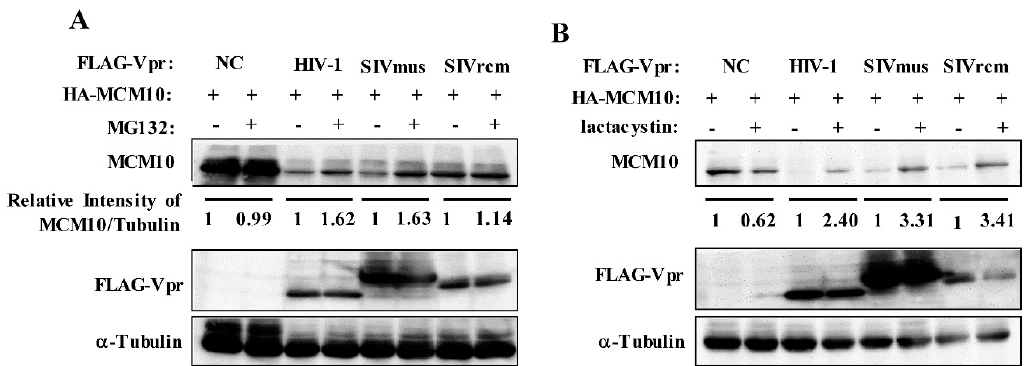
Figure 3. MCM10 degradation by HIV-1, SIVmus, and SIVrcm Vprs via proteasome dependent pathway. HEK293T cells were transiently transfected with pcDNA 3.1/HA-MCM10 together with either pcDNA3.1/3 × FLAG-HIV-1, SIVmus, and SIVrcm Vprs, or the control pcDNA3.1/3 × FLAG (NC: negative control). After 43 h of transfection, cells were treated with 10 µ M MG132 (a